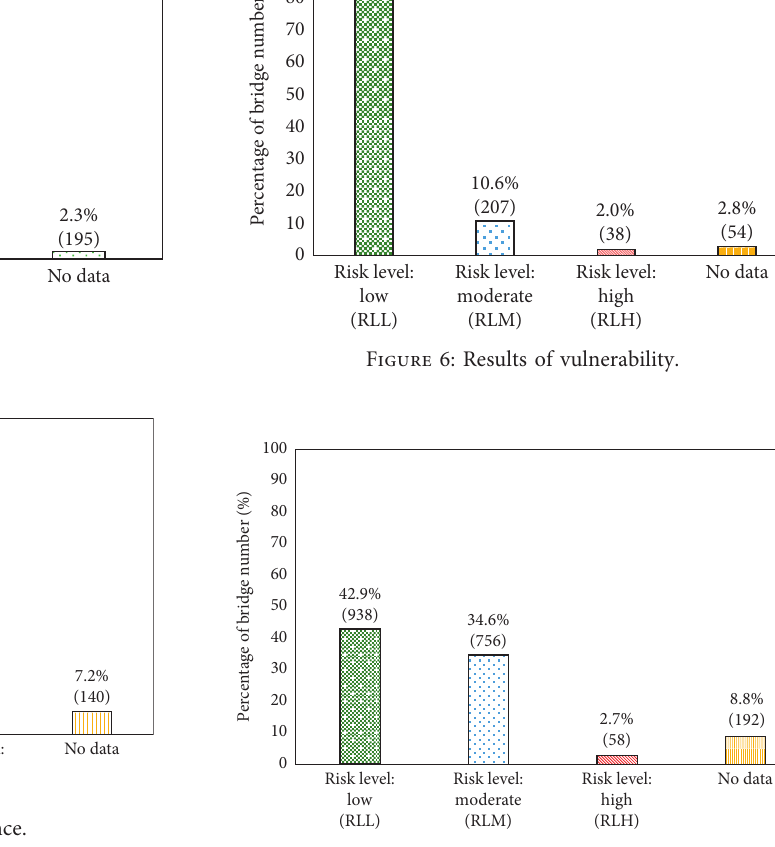
Figure 7: Final results of